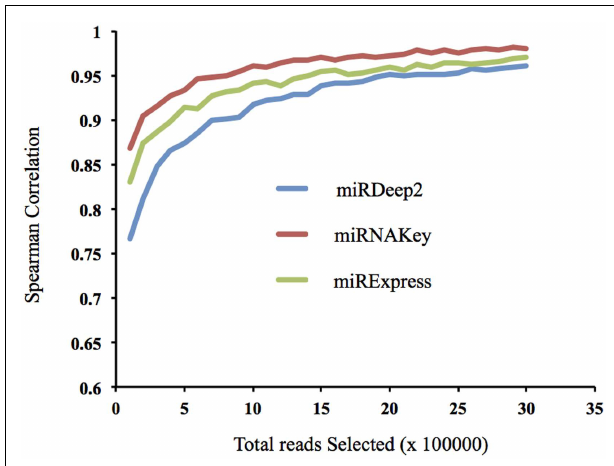
FIGURE 6 |The correlation of a subset of reads, beginning with 100,000 with the full number of mapped reads, 3.5